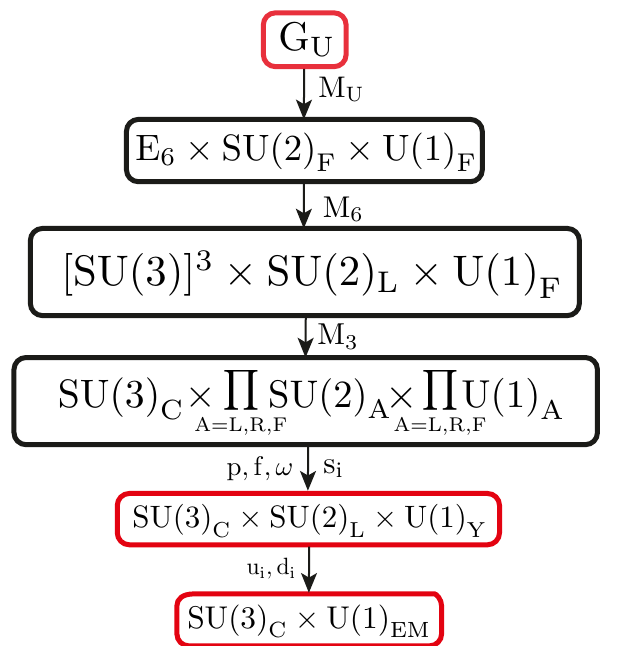
Figure 1. Symmetry breaking scheme from the original class of G U gauge symmetries down to the strong and electromagnetic gauge groups (SU (3) U (1) ). The various terms between the C × EM different boxes ( M , M , etc) represent the distinct mass scales involved in this scheme according 6 3 to the discussion in [17]. M encodes unknown details G symmetry U U